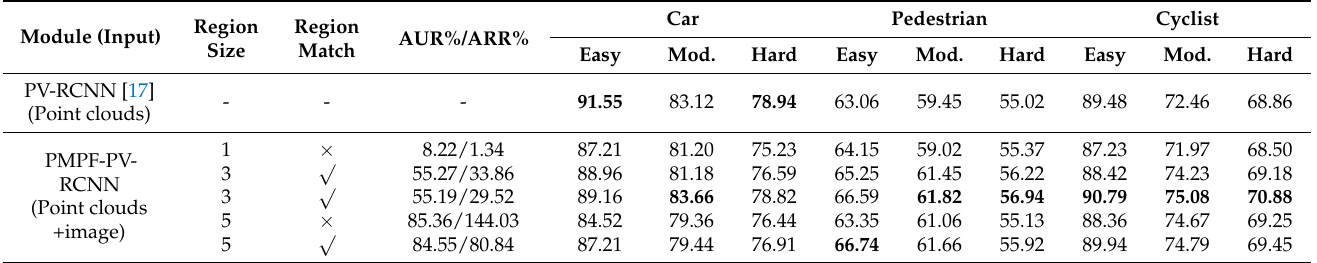
Table 7. An ablation study result for the effect of PMPF components on PV-RCNN on KITTI 3D object √ detection validation set. “ ” and “ × ” denote the results with or without the region match